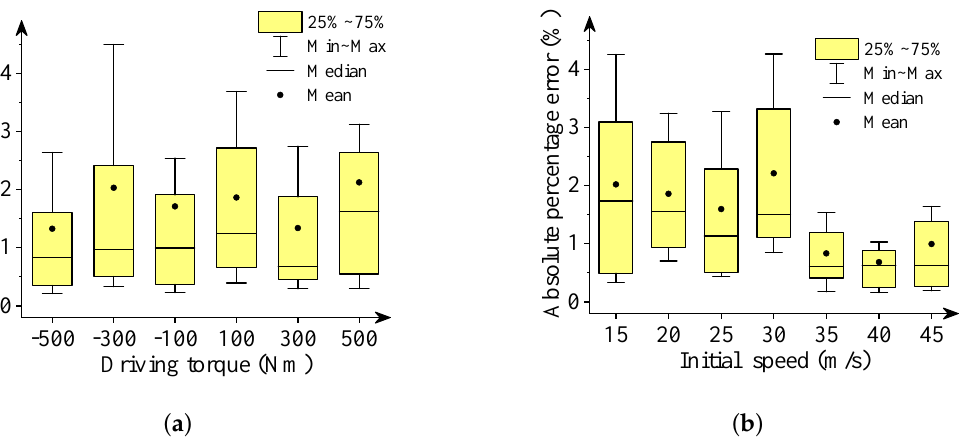
Figure 9. Box plots of absolute percentage error: final lateral velocities. ( a ) Driving torque; ( b ) Ini- tial speed.